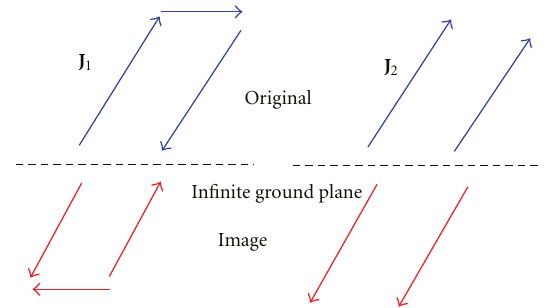
Figure 11: The main current paths for the first two modes of the SAU1/2